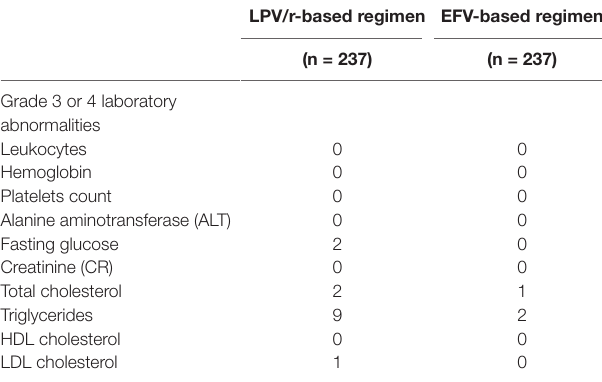
TABLE 2 | Laboratory abnormalities at 6, 12, 18, 24 months.